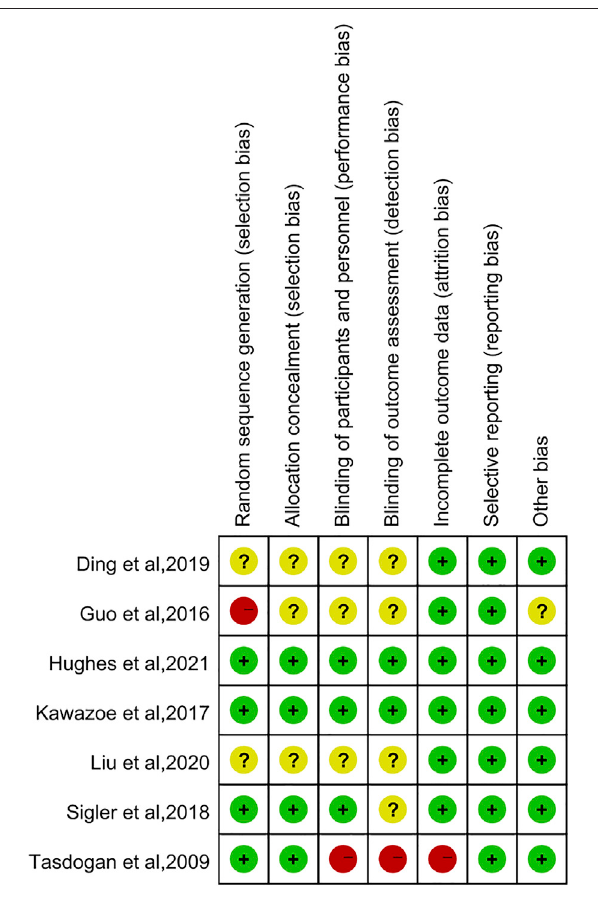
FIGURE 2 | Risk of bias